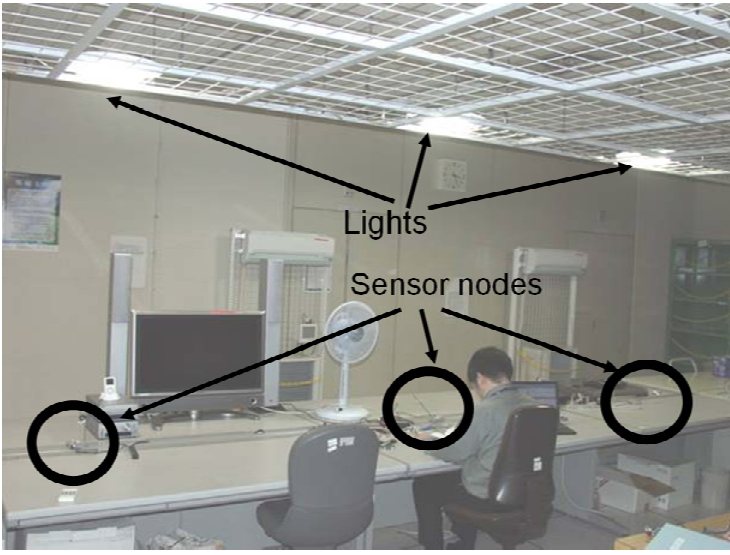
Figure 6. Photograph of the distributed lighting